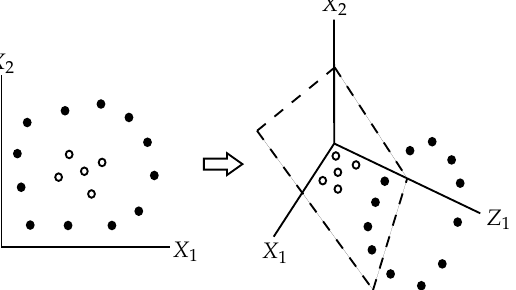
Figure 6. A visualization of the kernel trick’s principle. The dimensionality of the original covariates’ universe (simplified to) X 1 × X 2 is increased by one ( Z 1 ) or more dimensions, which could enable making the clouds of points from different classes linear separable and could help to find a separating “splitting” hyperplane (with dashed